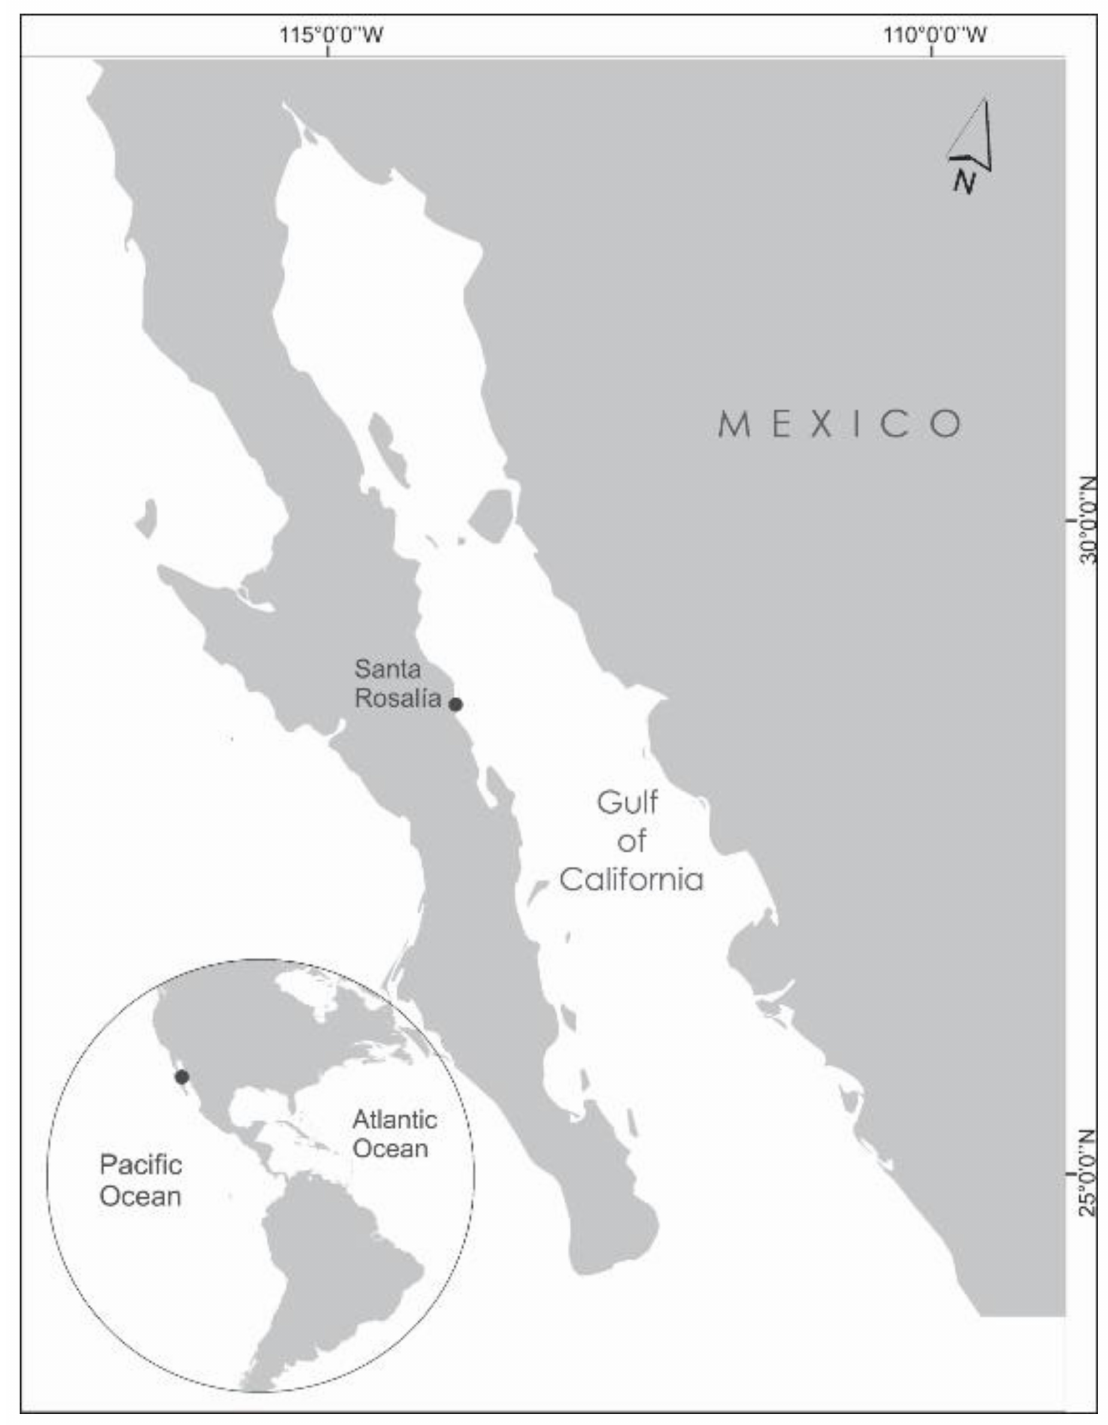
Figure 1. Location of the sampling site o ff Santa Rosalia, Baja California Sur,